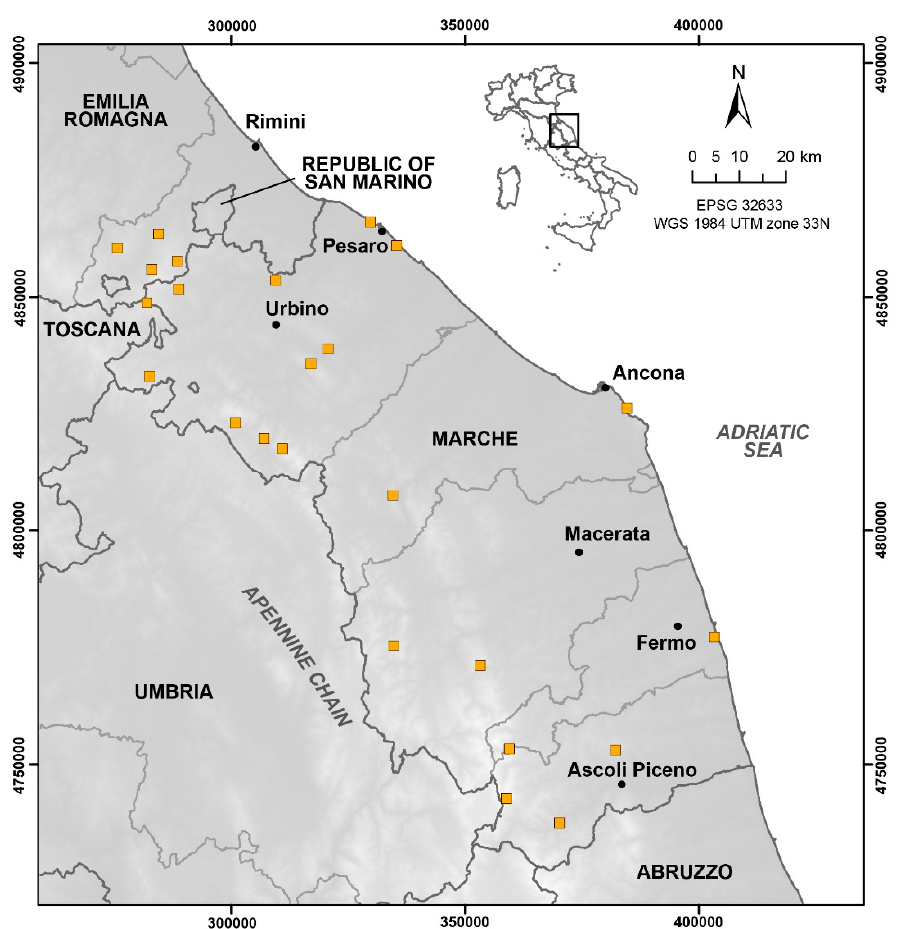
Figure 1. Study area and location (yellow squares) of the investigated sites (base map DEM from